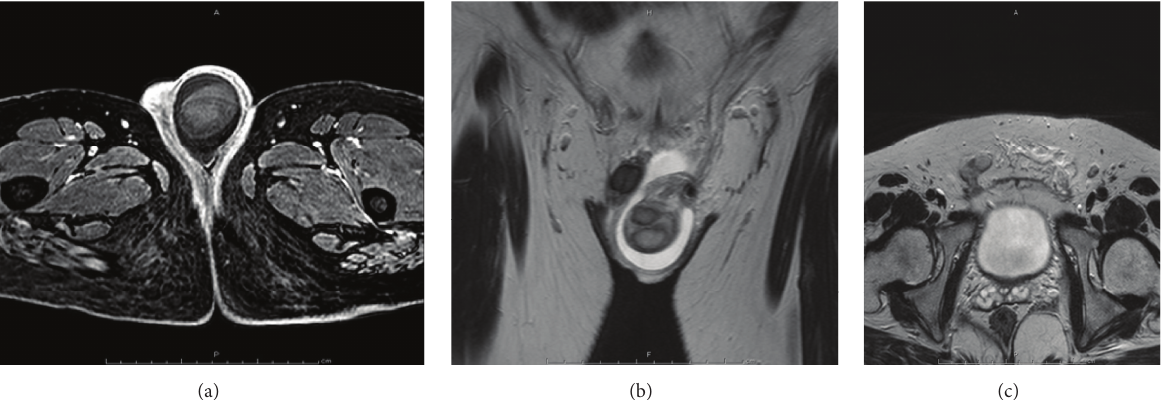
Figure 1: Contrast-enhanced magnetic resonance imaging. (a) No enhancement and inhomogeneous signal of the left testis. (b) Torsion of the left testis. (c) Cryptorchidism of the right testis.